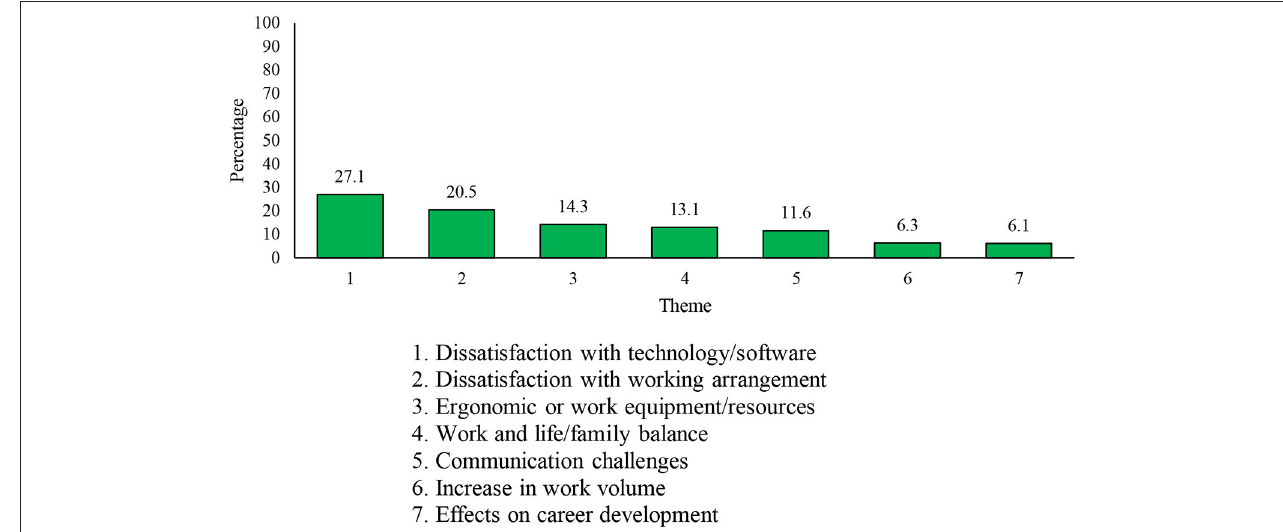
FIGURE 1 | Seven most frequently mentioned work-related